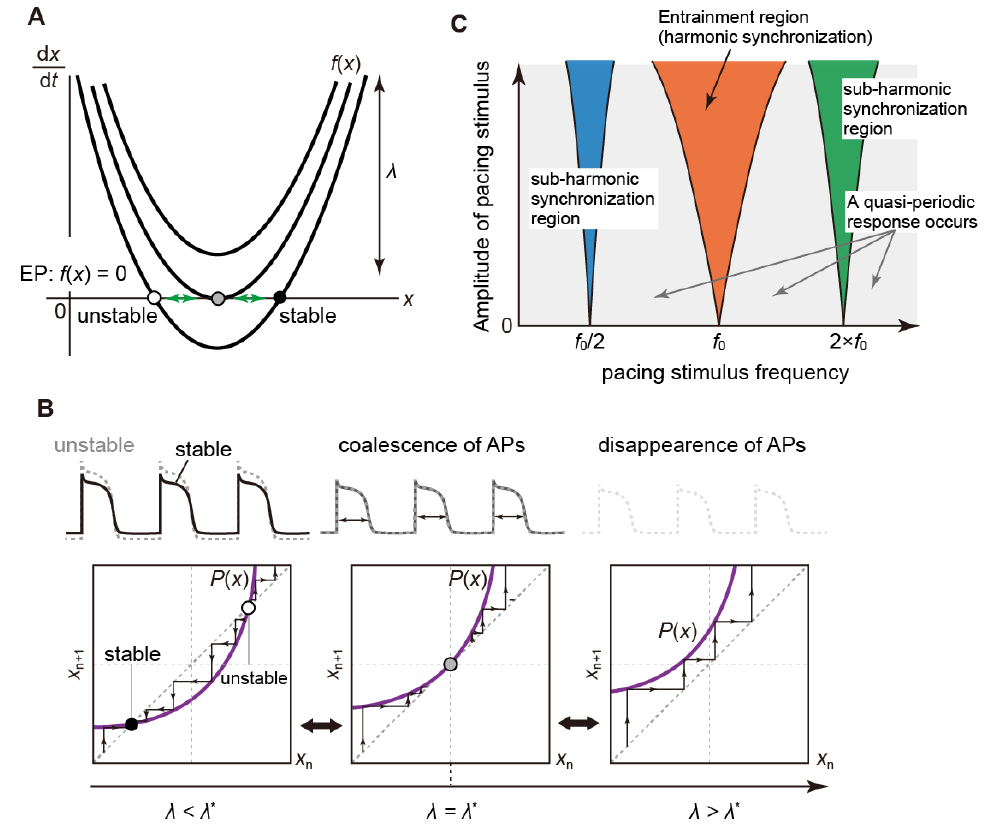
Figure 7. Saddle-node (SN) bifurcation. Schematic diagrams of the SN bifurcations of equilibrium ( A ) and fixed ( B ) points. As simple examples, in the dynamical systems d x /d t = f ( x , λ ) ( A ) and x n +1 = P ( x n , λ ) ( B ), the functions f ( x ) and P ( x n ) are varied up and/or down by changing system parameter λ . The SN bifurcation of equilibrium points occurs when the curve of f ( x ) touches the x -axis (d x /d t = 0 axis). On the other hand, the SN bifurcation of fixed points occurs when the curve of P ( x n ) touches the diagonal line ( x n +1 = x n ) at a value λ * of parameters. After that, a node and a saddle point emerge or disappear. A schematic diagram of Arnold’s tongue structure is also shown for a non-autonomous system with stimuli of various amplitudes and frequencies ( C ). Colored regions indicate parameter regions in which a periodic oscillation observed in an autonomous system can be entrained by external periodic stimuli, e.g., the orange region represents harmonic synchronized oscillation observed in the non-autonomous system. In general, the harmonic synchronized region and even the sub-harmonic synchronous region (e.g., blue and green regions) are divided in the parameter space by SN bifurcation sets. Oscillations that are asynchronous to the periodic stimuli, such as quasi-periodic oscillations, appear when set to parameters outside the synchronization region. f 0 : an intrinsic frequency of the limit-cycle oscillation in the autonomous